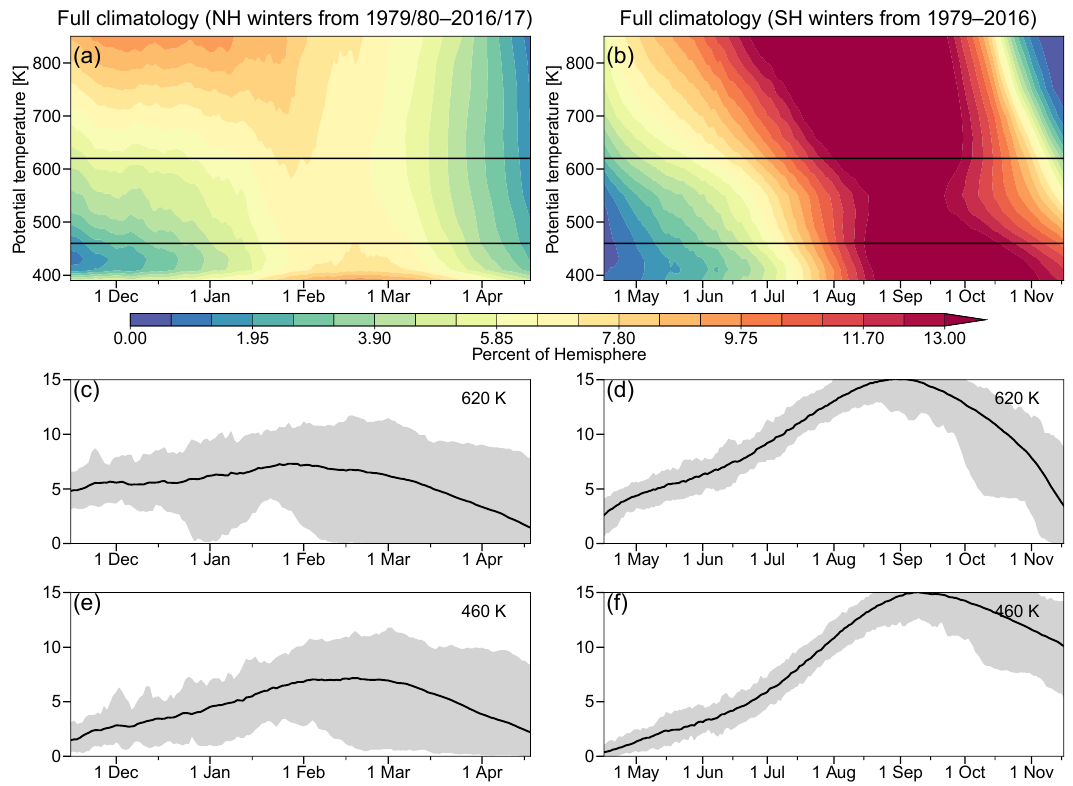
Figure 12. As in Fig. 9 but for sunlit vortex area. The color range in panels (a) and (b) is from 0% to 13% of a hemisphere (blues to reds), with all values over 13% shown in the deepest